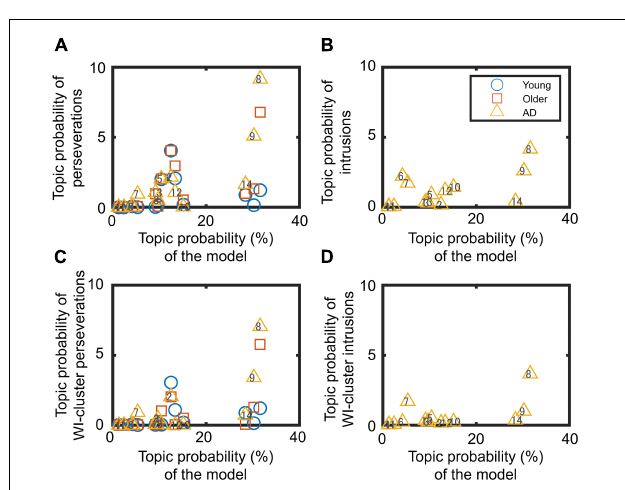
FIGURE 2 | Relationship between summed topic probabilities of the topic model and errors: (A,C) perseverations and (B,D) intrusions. Panels (C,D ) concern within-cluster (WI-cluster) errors. Each marker indicates the data for one topic (from 1 to 14